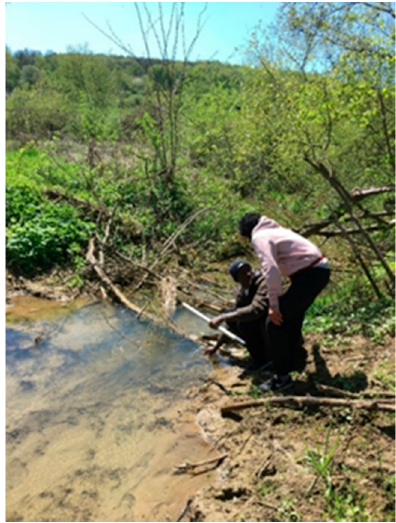
Figure 8. Valchid River non-refuge sector.